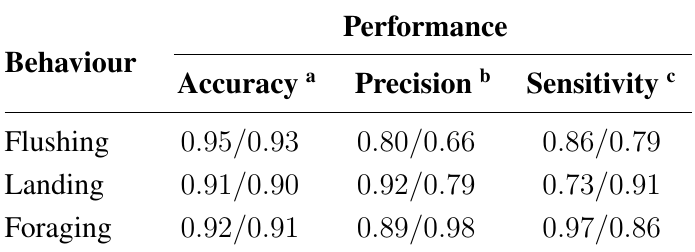
Table 3. Model performance for each behaviour classification. The same notation A/B as in Table 2 is used in this